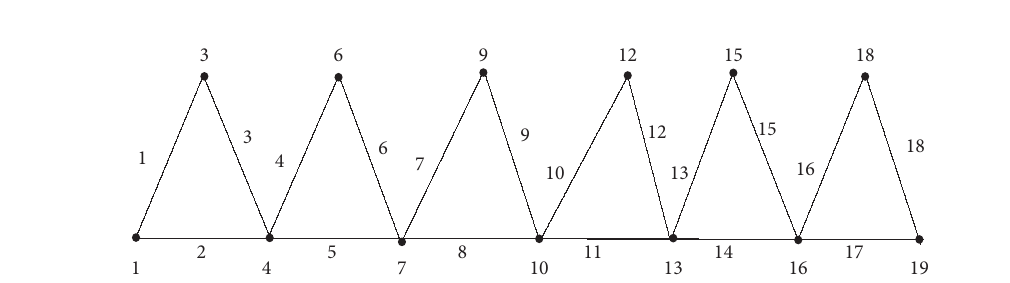
Figure 10: A classical mean labeling labeling of T